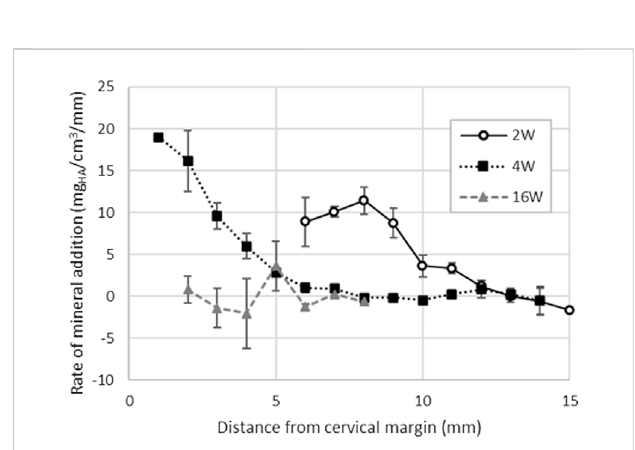
FIGURE 7 Enamel rate of mineral addition along the cervical-occlusal direction of the tooth computed for fi rst incisors extracted from pigs aged 2, 4 and 16-week. The results indicate that the mineral addition reaches a maximum around 8 mm form the cervical margin in 2- week-old pigs. At 4-week, the tooth eruption is slowed down and enamel mineral addition is twice as fast as in 2-week-old pigs. In 16- week-old pigs, the fi rst incisors are both fully formed and erupted as con fi rmed by the constantly null mineralization